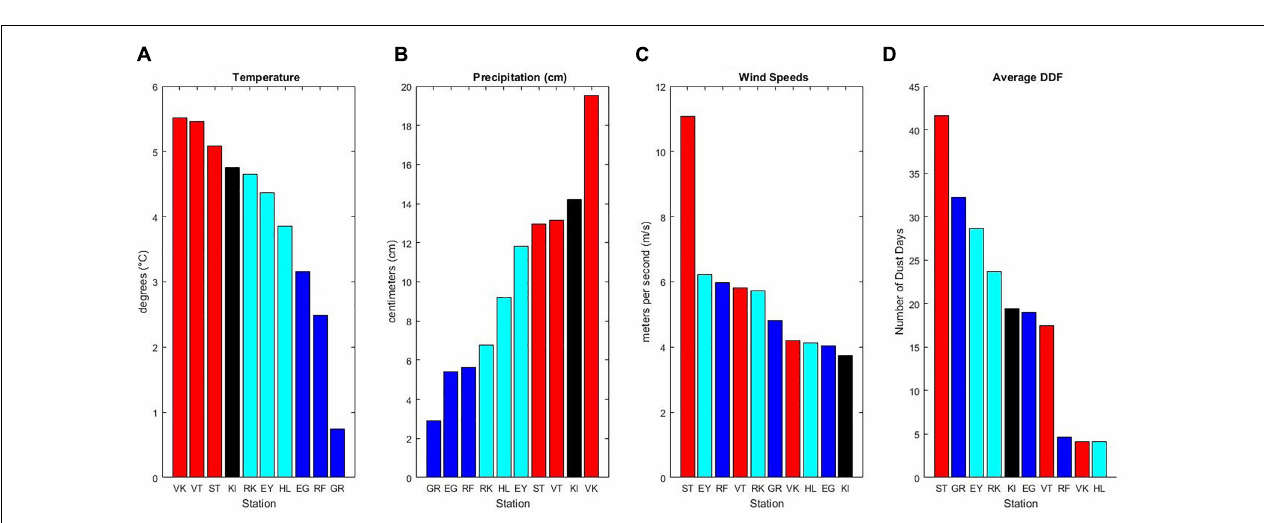
FIGURE 5 | Average annual (A) Temperature, (B) Precipitation, and (C) Wind Speed over 60 year period. (D) Average number of dust days per year at each station: Grímsstaðir (GR), Raufarhöfn (RF), Egilsstaðir (EG), Reykjavik (RK), Eyrarbakki (EY), Hæll (HL), Stórhöfði (ST), Vatnsskarðshólar (VT), Vík í Mýrdal (VK), Kirkjubæjarklaustur (KI). NE stations in blue, SW stations in cyan, and South stations in red, with Kirkjubæjarklaustur black.